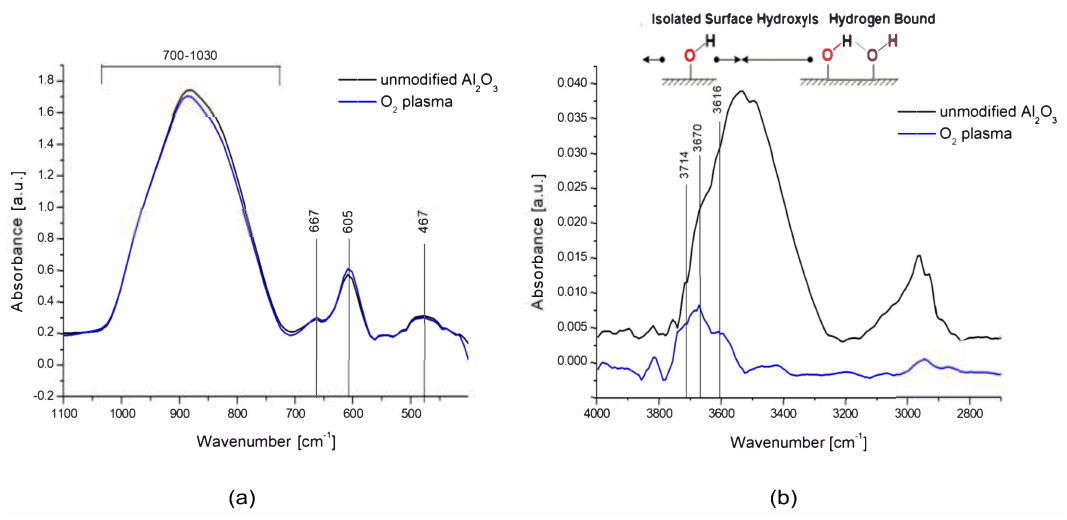
Figure 4. FTIR spectra for unmodified and modified O 2 plasma ceramics in the ranges 1100–400 cm − 1 ( a ) and 4000–2700 cm − 1 ( b